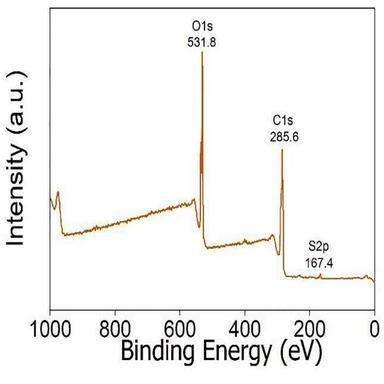
Triple plot showing Raman-based information related to the number of layers (abscissa), crystallinity (ordinate), and oxidation level (color bar) of each of the analyzed GO nanosheets.